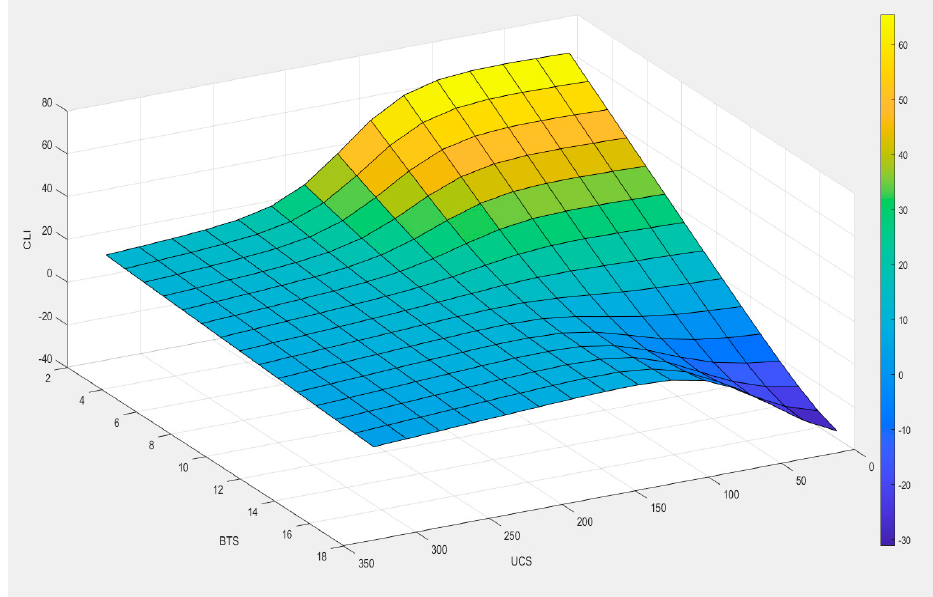
Figure 18. Fuzzy logic surface view for inputs (UCS and BTS) and CLI.